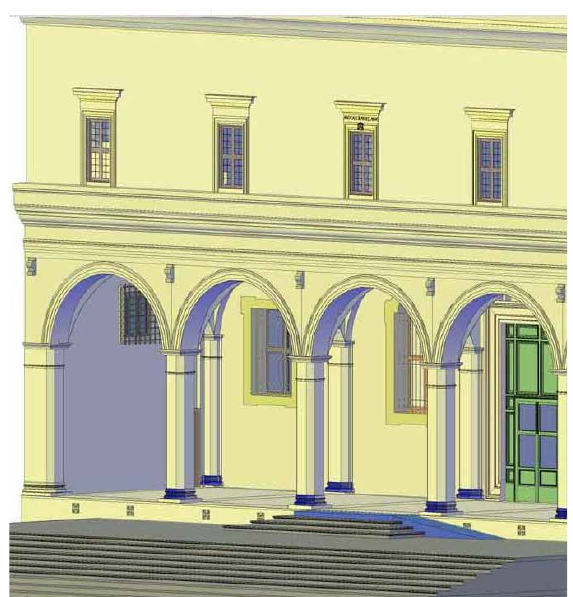
Figure 23. Detail view of the virtual model of the entrance of